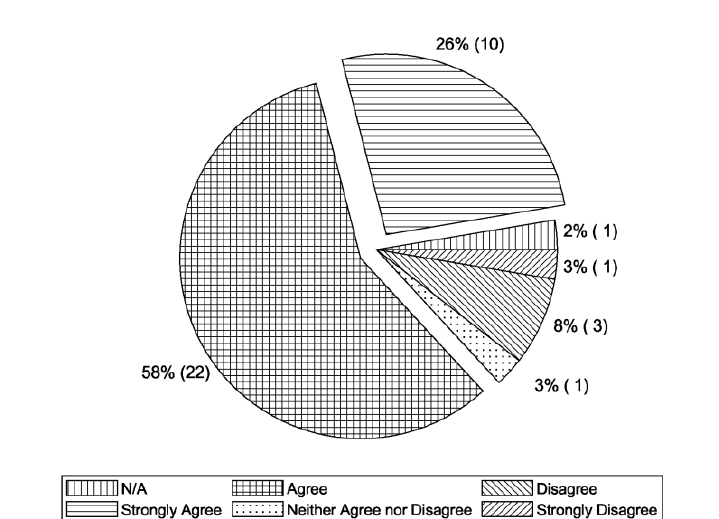
Fig. 9. Presentations help students know better the engineering major that they